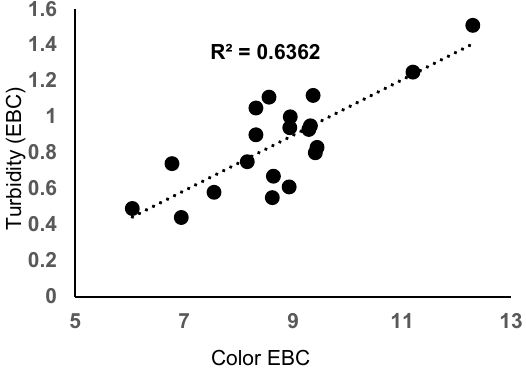
Figure 6. Correlation between beer color and beer turbidity.